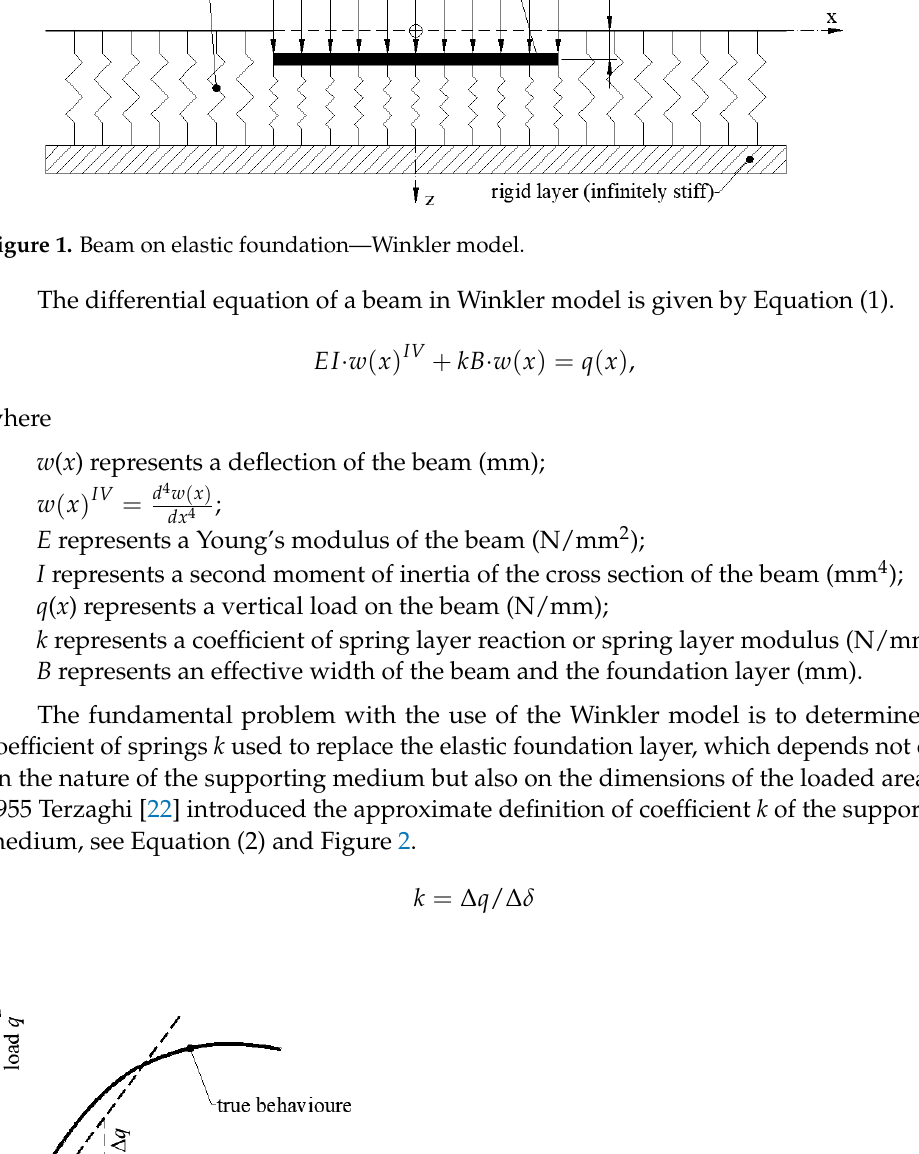
Figure 2. Load–deformation response of the supporting medium.